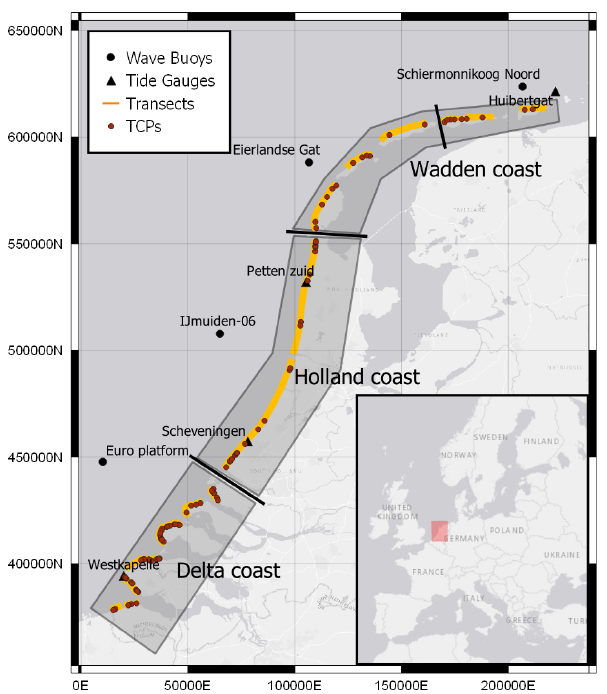
Figure 2. Map of the Dutch coast indicating the location of the JARKUS transects (yellow lines), the offshore stations (wave buoys and tide gauges, black circles and triangles, respectively), and the 100 typological coastal profiles (TCPs, red dots) used as the train- ing dataset in the present study. The thick black lines perpendicular to the coastline separate the different Dutch coastal areas, each one associated with one offshore station. The map is projected on the “Amersfoort/RD New” coordinate system (EPSG: 28992) with the x and y axis in meters. The basemap shown is obtained from ESRI (ESRI,